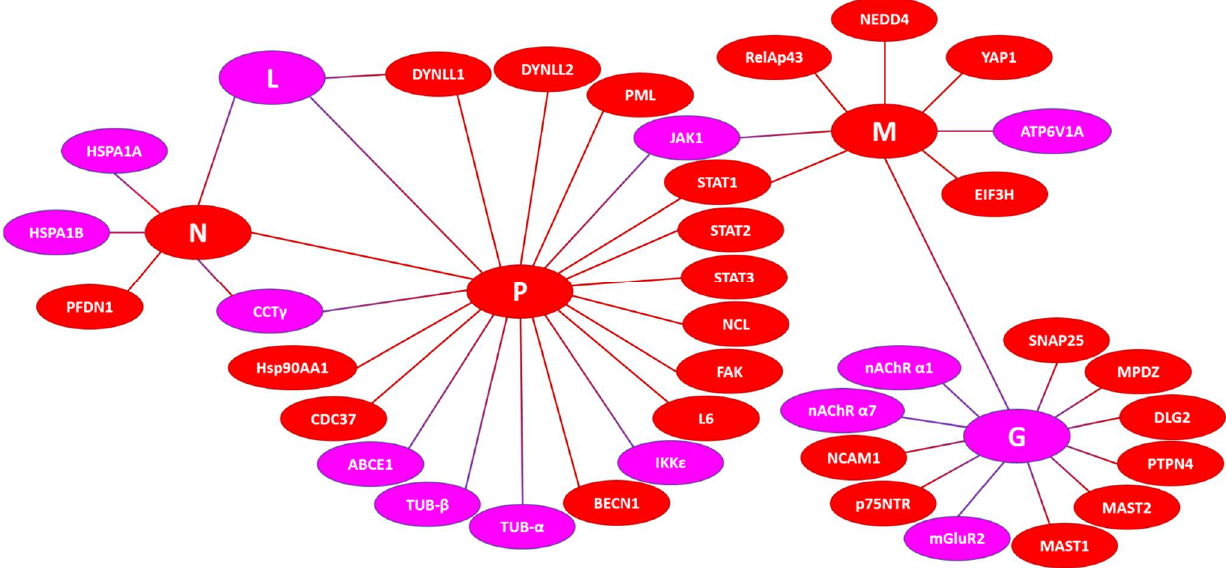
Figure 9. Disordered interactome of the RABV N-, L-, P-, M-, and G-proteins. Proteins are colored based on their PPIDR values, with highly and moderately disordered proteins being shown by red and pink colors, respectively. Note that none of the proteins in this diagram is classified as mostly ordered (there are no proteins colored in blue).